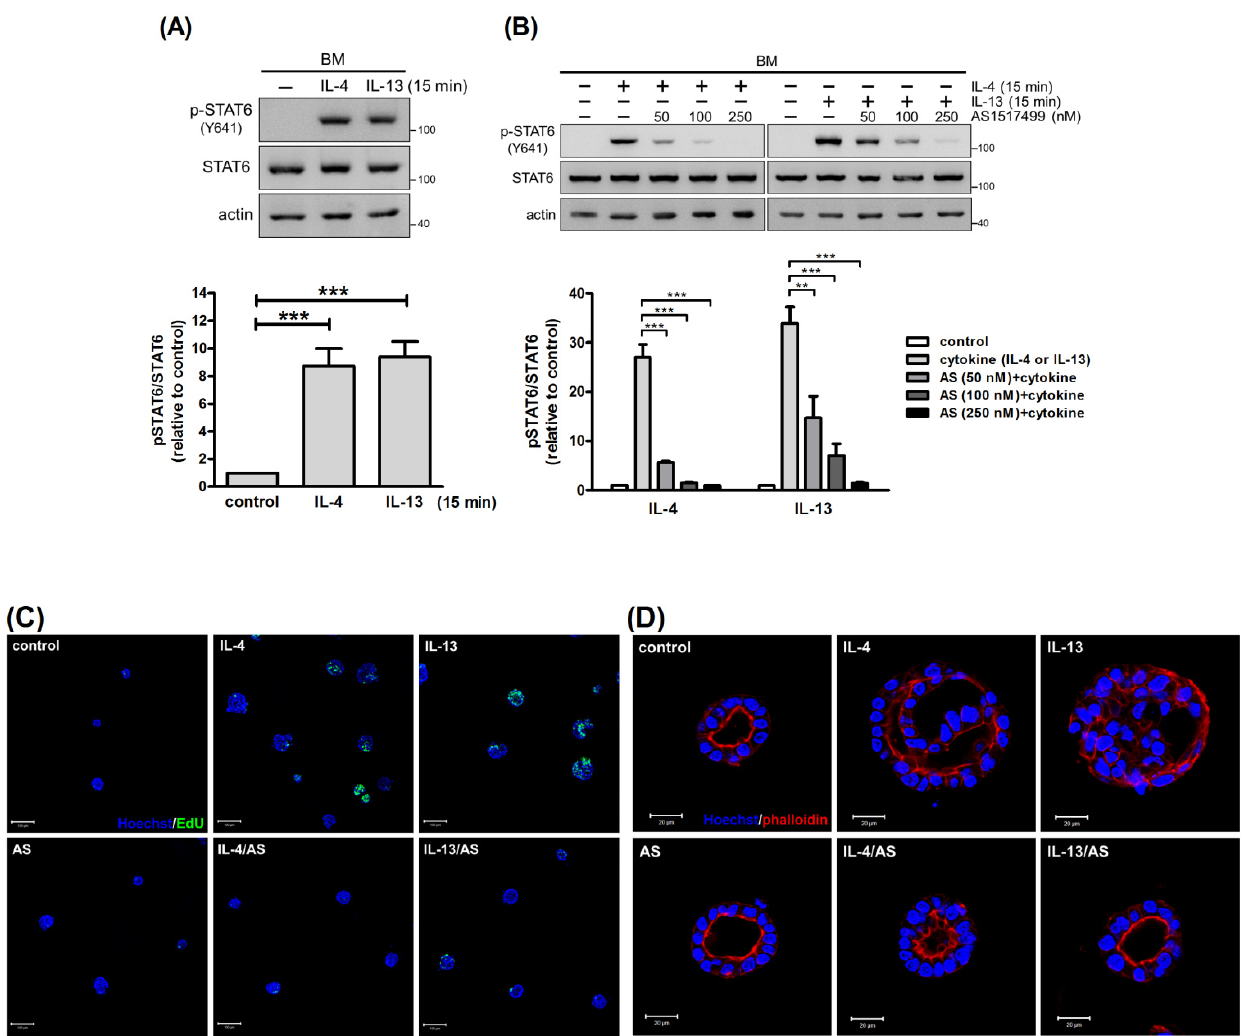
Figure 3. Inhibition of STAT6 alleviates the pro-proliferative effect of IL-4 and IL-13. ( A ) Mammary cells cultured on a basement membrane (BM)-like matrix, Matrigel, were untreated or treated with IL-4 or IL-13 for 15 min ( n = 4). ( B ) Mammary cells cultured on Matrigel were pretreated with STAT6 inhibitor AS1517499 (50~250 nM) for 1 h and stimulated with IL-4 or IL-13 for 15 min ( n = 3). Total cell lysates were analyzed by immunoblotting with antibodies to phospho-STAT6 (p-STAT6), STAT6 and actin. Actin was used as a loading control. Data were quantified, normalized to loading control and expressed as fold change (pSTAT6/STAT6) relative to control. ** p < 0.01, *** p < 0.005. ( C , D ) Mammary cells cultured on Matrigel were pretreated with AS1517499 (100 nM) for 1 h and stimulated with IL-4 or IL-13 for 1 d. ( C ) Prior to harvesting, cells were pulsed with EdU (green) for 8 h. Nuclei were stained with Hoechst 33342 (blue). Scale bar, 100 µ m. ( D ) Cells were stained with rhodamine phalloidin (red) and Hoechst 33342 (blue), and subjected to confocal microscopy. Images were taken from the center of acini. Scale bar, 20 μ m.